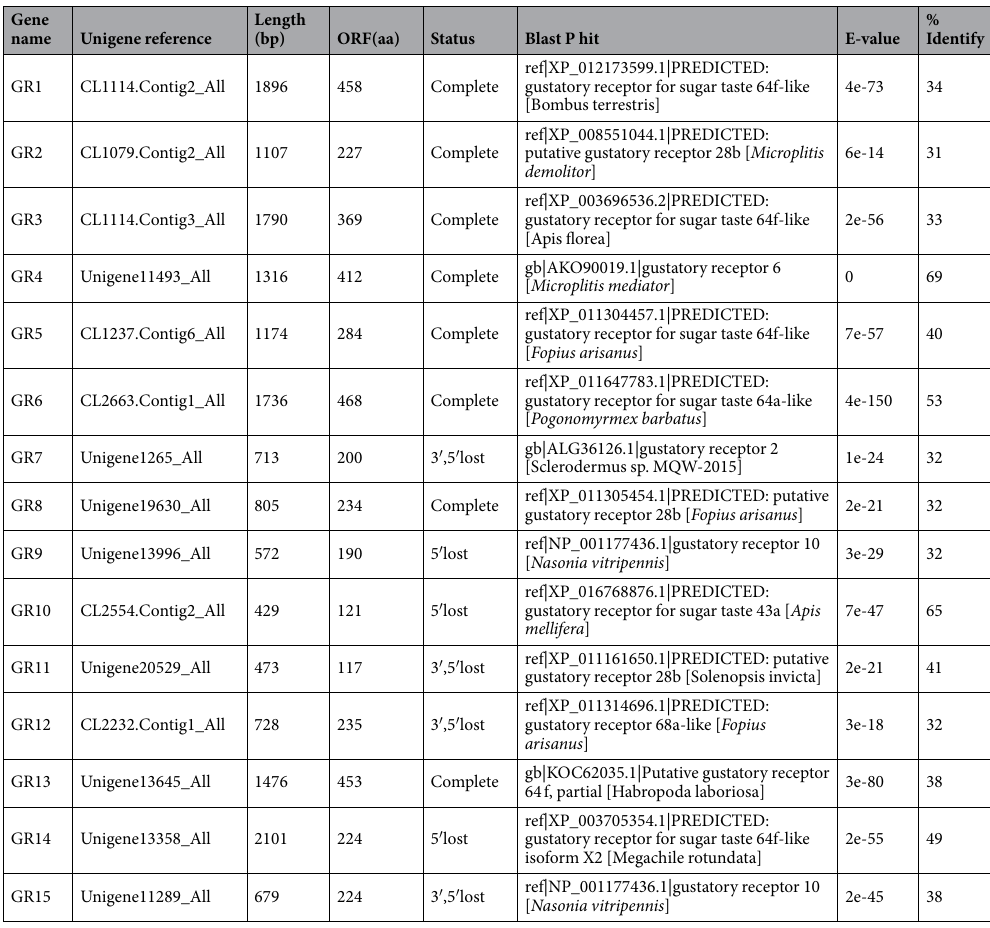
Table 2. Candidate gustatory receptor transcripts identified in adult male and female A . gifuensis antennal